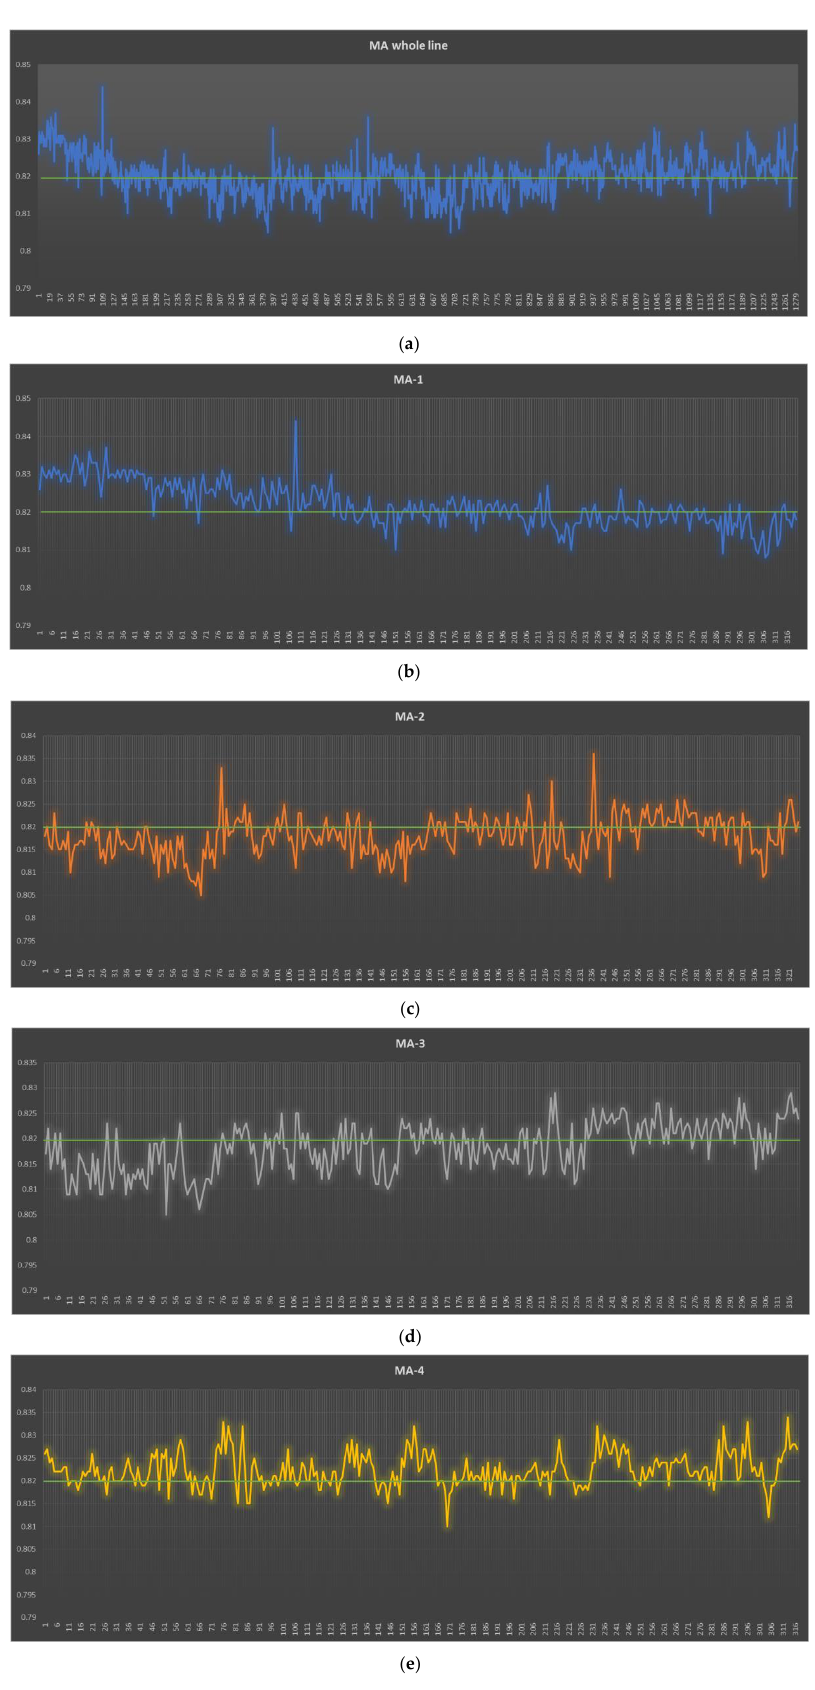
Figure 10. Improved state-run chart of storage volume on machines ( a ) MA whole line, ( b ) MA-1, ( c ) MA-2, ( d ) MA-3, and ( e ) MA-4.